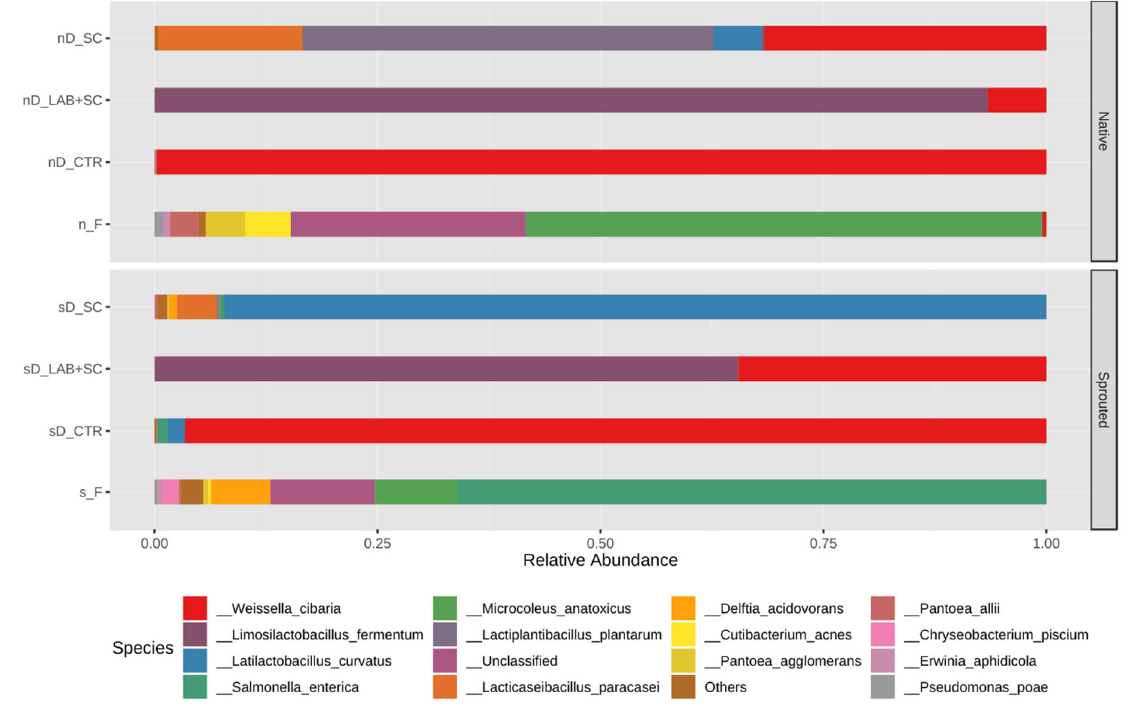
Figure 2. Relative abundance of bacterial species found in dough and flour samples. The bar plot represents the top 15 most abundant taxa among all samples identified to the species level. “Others” refers to merged species that individually showed a relative abundance below 0.25%. “Unclassified” are bacterial taxa not identified at the phylum level. The results are expressed as average of replicates for each type of dough. In the x ‐ axis are reported the name of the samples as follow: sD, sprouted rye dough; nD, native rye dough; s_F, sprouted rye flour; n_F, native rye flour, CTR, dough control; LAB + SC, dough fermented with LAB + SC; SC, dough fermented with SC.